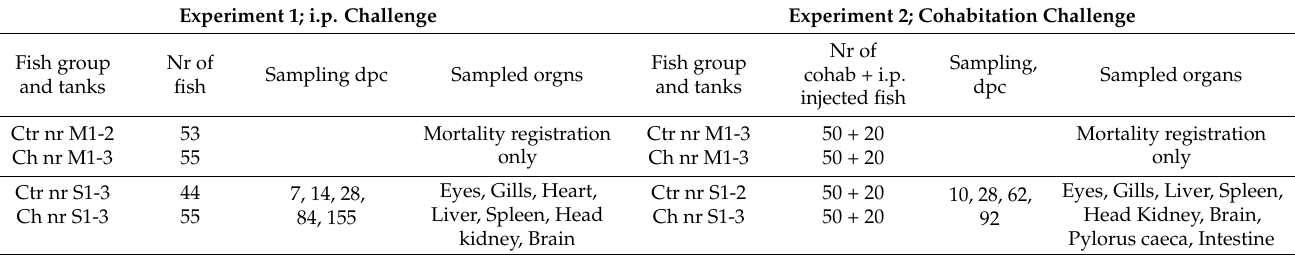
Table 1. Experimental design of experiment 1 and 2. ip = intra peritoneal, cohab = cohabitant fish, Ctr = control group, Ch = challenge group, M = tanks used for mortality registrations, S = tanks used for sampling only, dpc = days post